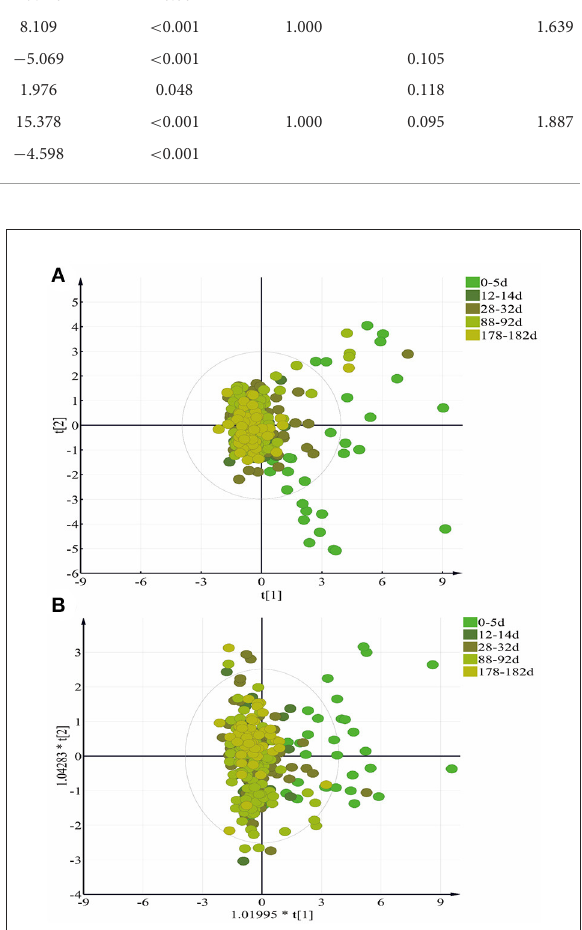
FIGURE4 (A) Score plots for HM vitamin collected in different lactation period based on PCA model. (B) score plots for HM vitamin collected in different lactation period based on OPLS-DA